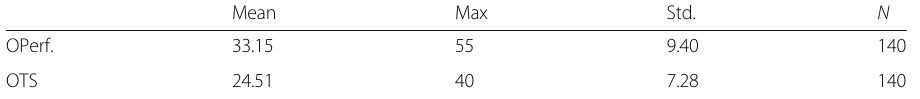
Table 4 Descriptive statistics for observed performance on the test and observed test scores in the TOEFL iBT test Mean Max Std. N